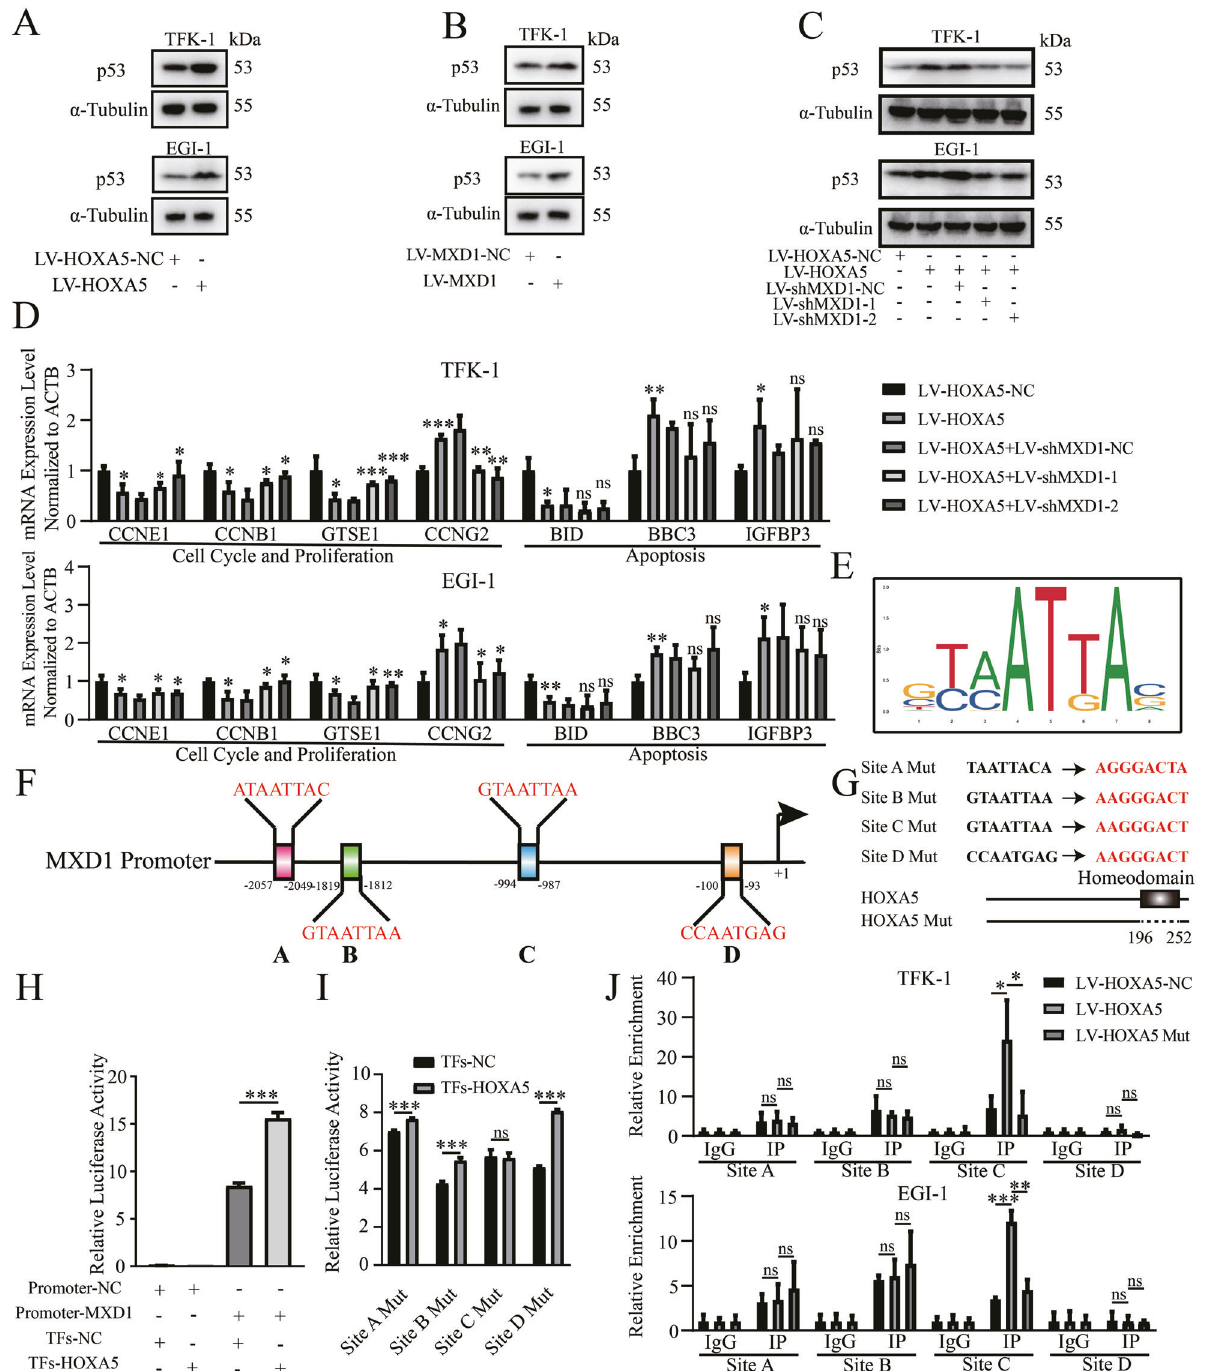
Fig. 7 The HOXA5/MXD1 axis enhances p53 expression and HOXA5 directly induces MXD1 transcription in ECCA cells. A – C HOXA5 or MXD1 overexpression increased p53 protein expression, and the enhanced effect of HOXA5 overexpression on p53 protein expression was mitigated by MXD1 silencing in ECCA cells. D Validation of the target genes involved in the p53 pathway. E The predicted binding sequences of HOXA5 in the MXD1 promoter from the JASPAR database. F The predicted binding sites in the MXD1 promoter from the JASPAR database. G The sequences of four sites and the scheme of the mutations in this study. H , I Luciferase reporter assays indicated that HOXA5 expression enhanced the MXD1 promoter-controlled luciferase expression, which was abrogated by the site C mutation in the MXD1 promoter in HEK293T cells. J ChIP validated that HOXA5 expression increased its binding to the MXD1 promoter at the predicted site, which was inhibited by the mutation in the DNA binding domain of HOXA5. * P < 0.05. ** P < 0.01. *** P < To learn the binding pattern of HOXA5 in the genome, we performed CUT & Tag analysis. A total of 7073 peaks, involved in of CCNG2, a cell cycling inhibitor involved in negative feedback of different binding sites of 4579 genes, were found in Flag-HOXA5 p53, was up-regulated, which could be regarded as a compensa- over-expressed TFK-1 cells. The distribution of these peaks is tory reaction to p53 activation (Fig. 7D).